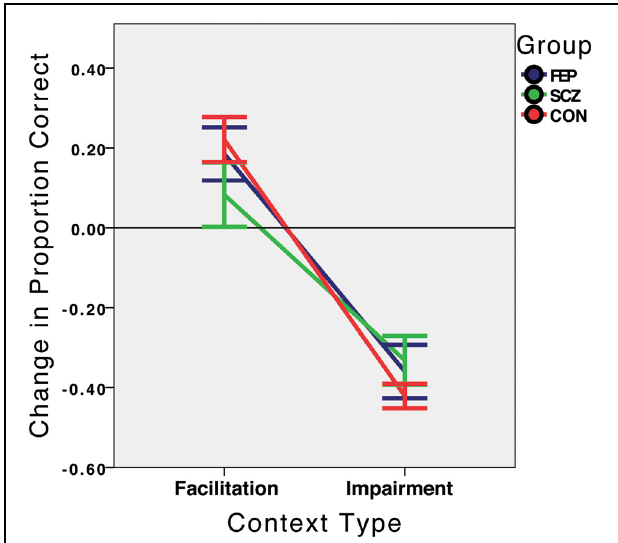
FIGURE 4 | Context sensitivity at Time 2 (hospital discharge for the SCZ and FEP groups, approximately 2 weeks after Time 1), by group. Performance in the facilitation and impairment context conditions is expressed relative to performance in the no-context condition, which is represented by the value 0.0 on the Y axis. FEP, First Episode Psychosis; SCZ, Schizophrenia (multiple episode); CON, Healthy